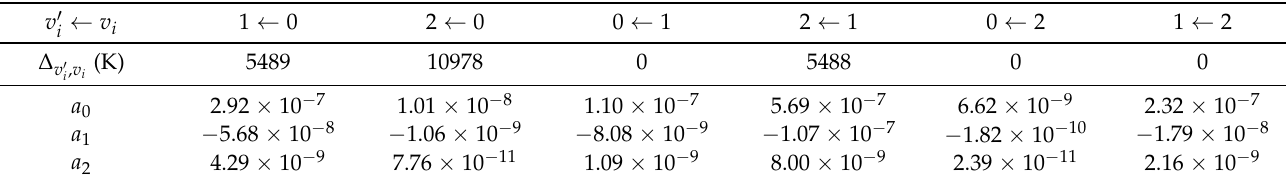
Table 3. Same as Table 2 for the symmetric stretching mode of H 2 O.